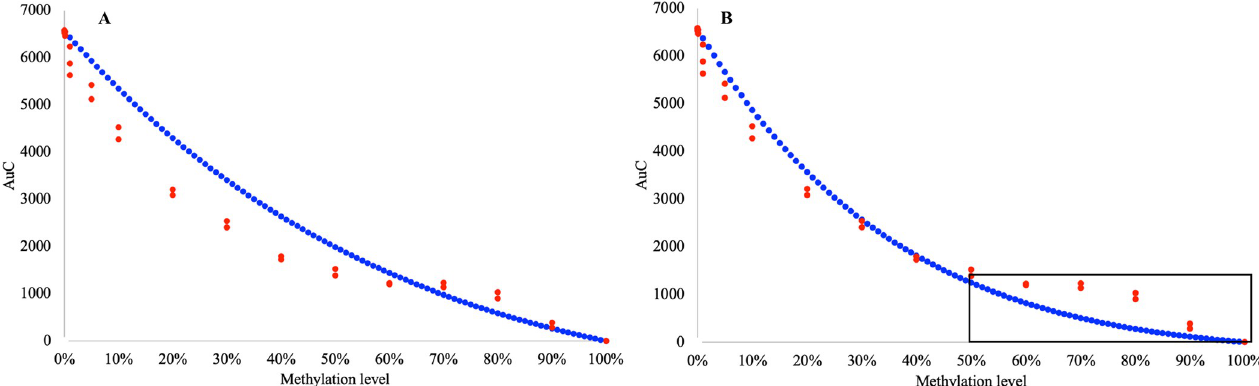
Fig 3. Comparison of the standard curve calculated using Eq 2 and observed AUC for each of the control mixes in the experiment for the EpiMelt MGMT assay. (A) The standard curve (blue) describes the association relationship between AUC and methylation level calculated using Eq 2 and observed values of the AUC (red dots–triplicates for each of the control mixes) with M-value set to 1 for the EpiMelt MGMT assay. (B) The standard curve with M-value was calculated for this specific experiment with LSA. The black box shows the region with the highest discrepant regarding estimation of AUC values.